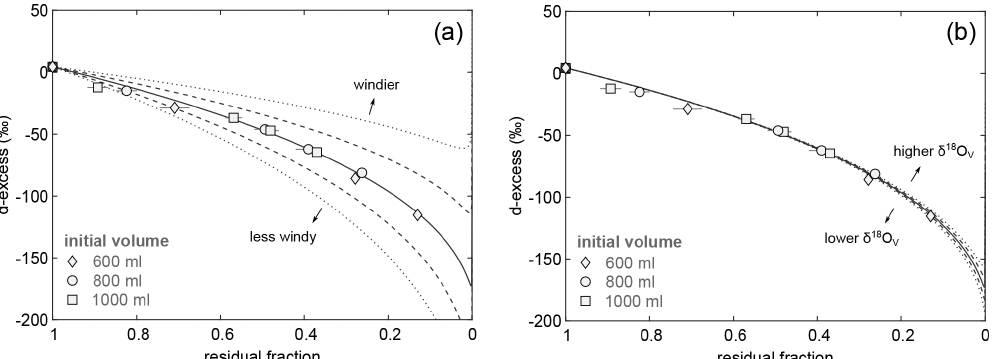
Figure 7. Sensitivity of evaporation trajectories in a plot of d-excess over residual fraction to (a) the turbulence coefficient ( n ) and (b) the iso- topic composition of atmospheric vapour ( δ 18 O V ). Isotopic data of pan evaporation experiments with initial volume of 600mL (diamonds), 800mL (circles), and 1000mL (squares) are shown for comparison. Note that the symbol size is in most cases larger than the error bars. The solid line represents the modelled evaporation trajectory for simple evaporation using input parameters as summarized in Table 2 and a turbulence coefficient of 0.44. Dashed lines show model results for (a) different turbulence coefficients in intervals of 0.1 and (b) varying δ 18 O V in intervals of 5‰, keeping other parameters